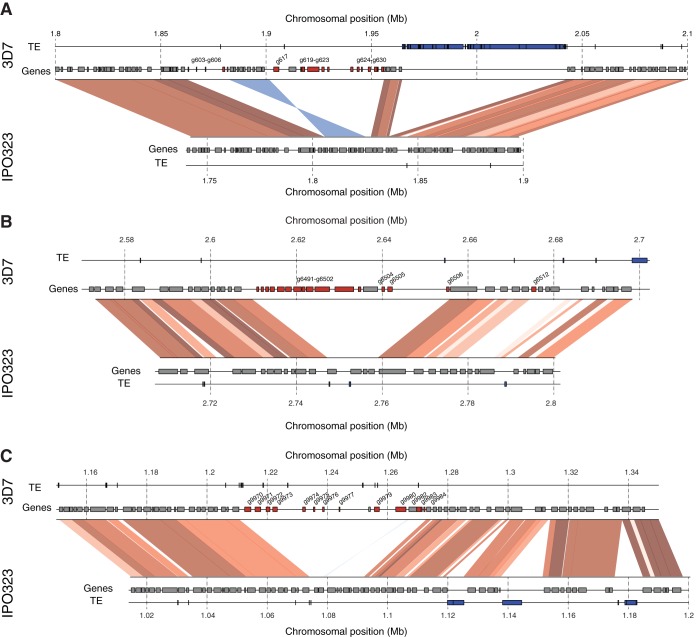
Chromosomal synteny analyses of regions harboring large orphan gene clusters. Collinear sequences between 3D7 and IPO323 are shown by red segments. Light to dark red shades indicate levels of sequence identity (90 to 100%). Inverted sequences are shown by blue segments, and shades of blue indicate sequence identity (90 to 100%). For each genome, the locations of genes and transposable elements (TE) are shown as independent tracks. (A) A cluster of 12 consecutive orphan genes (ZT3D7_g619 to ZT3D7_g630) located on chromosome 1. An inversion polymorphism affecting 19 kb and 9 genes was located in proximity. The orphan gene cluster was also in proximity to a large TE cluster. (B) On chromosome 5, subtelomeric clusters contained 3 and 12 orphan genes, respectively. Gene ZT3D7_g6501 encodes a peptidase C19. (C) On chromosome 10, a total of 13 orphan genes were clustered with interspersed core genes that have homologs in IPO323. Synteny between 3D7 and IPO323 was interrupted multiple times by nonsyntenic TE clusters.